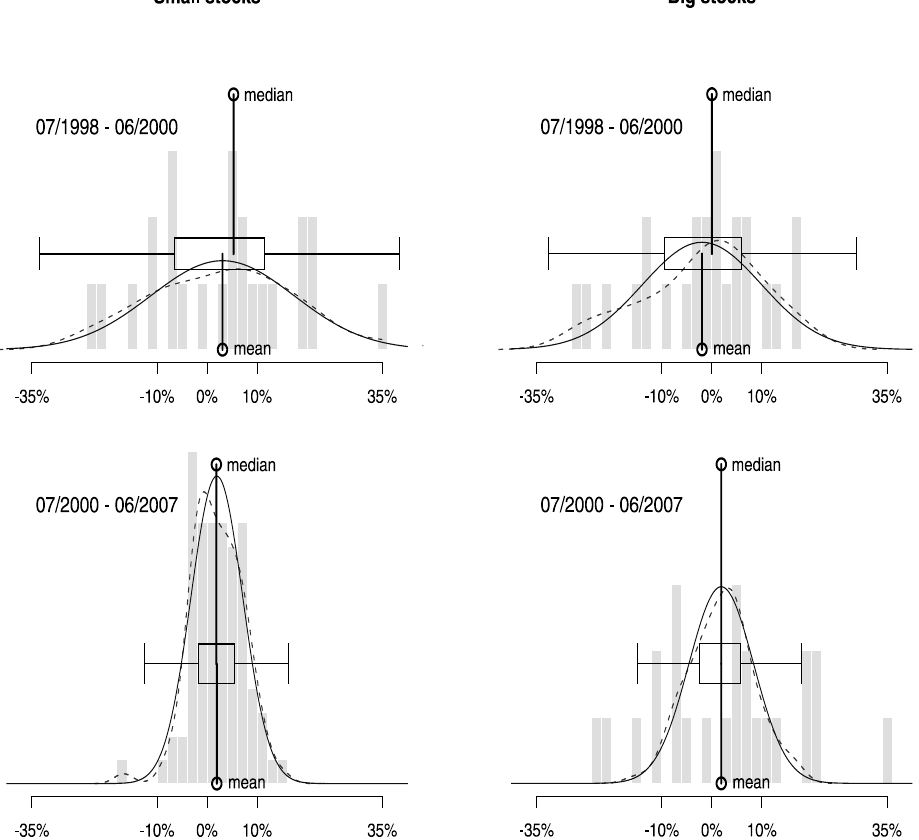
FIGURE 2: Distribution of the Value Premium among small and big firms during the two sub-